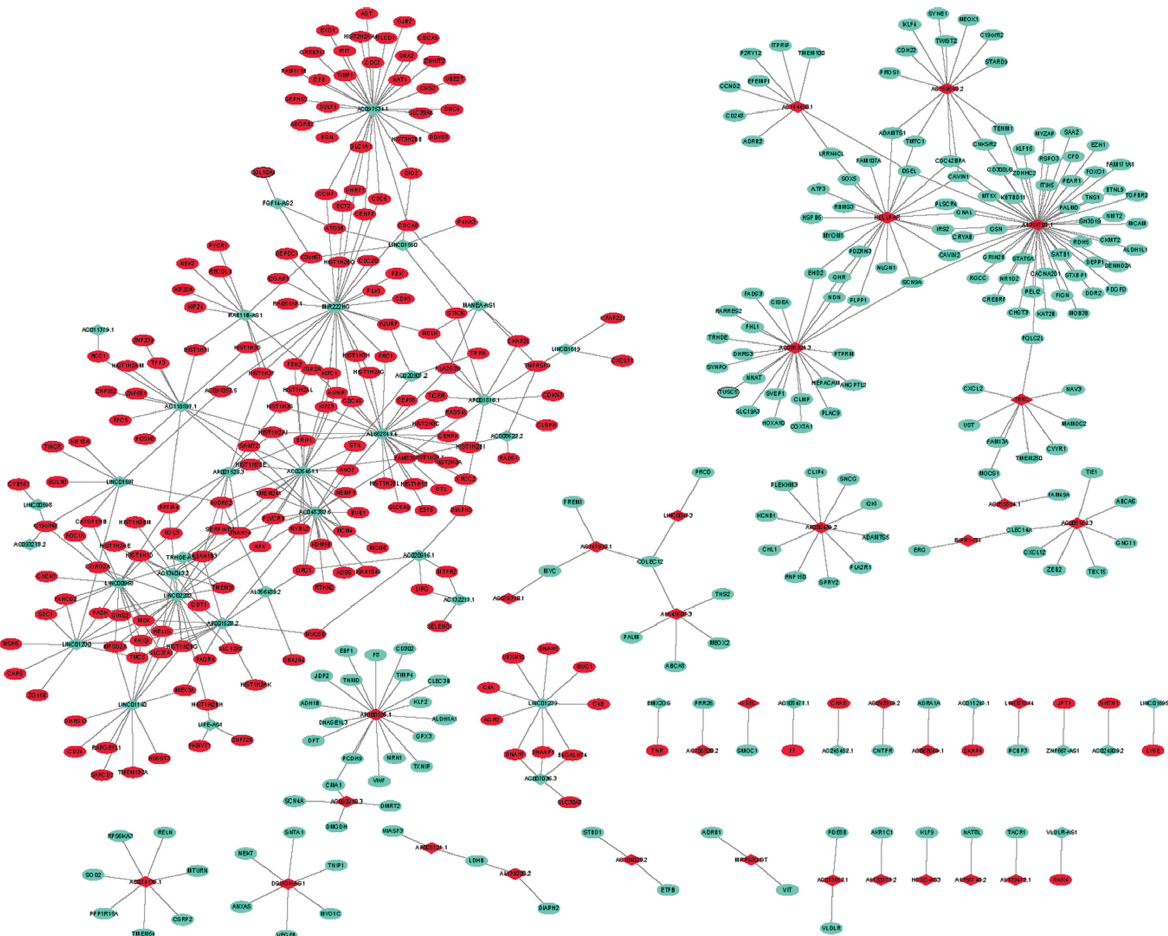
Figure 6: Negatively coexpressed DElncRNA-DEmRNA network. Ellipse and rhombus represent DEmRNA and DElncRNA, respectively. Red and green colors represent upregulation and downregulation, respectively. The black border indicates the top 10 upregulated and downregulated DElncRNAs and DEmRNAs.